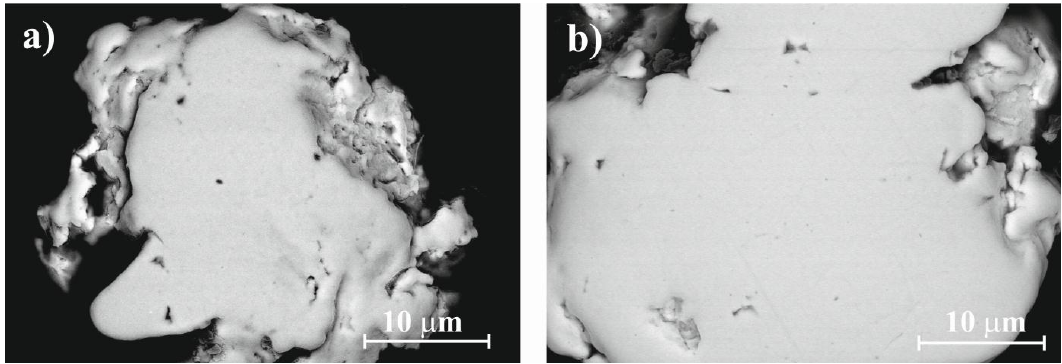
Figure 2. SEM micrographs of the amorphous powders ( a ) Cu 39.2 Zr 36 Al 4.8 Ni 10 Ti 10 ; ( b ) Cu 39.2 Zr 35.2 Al 5.6 Ni 10 Ti 10 .